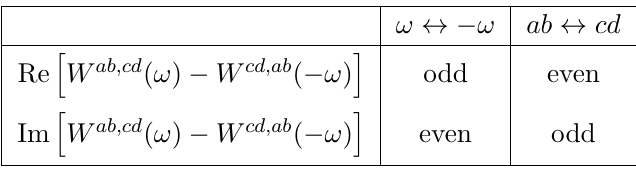
Table 1 . Behavior of real and imaginary parts under the substitution ω → − ω or index exchange ab ↔ cd . Even/odd means that the function changes/does not change sign under the given trans-